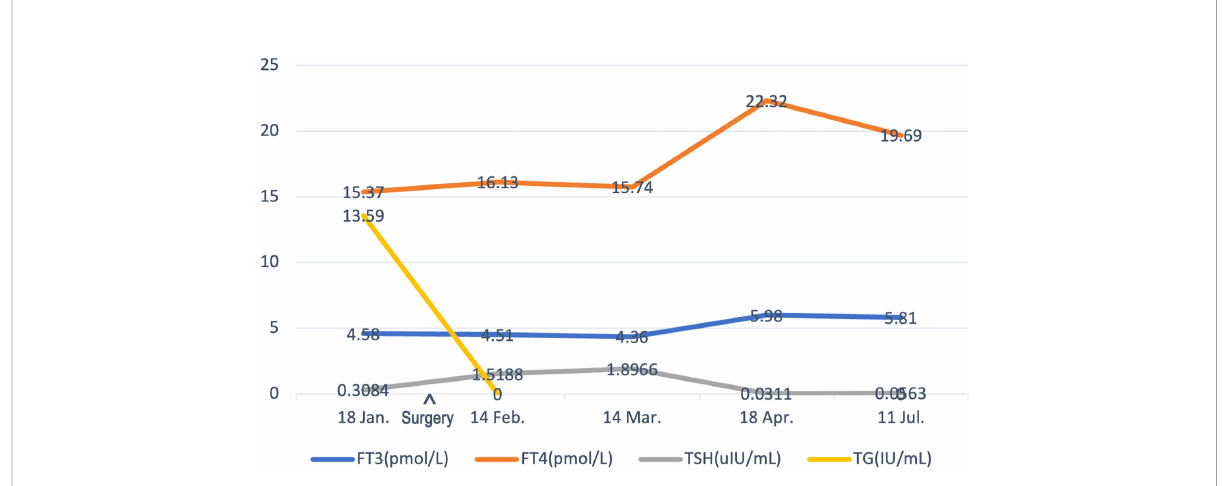
FIGURE 4 The timeline showcases the results of FT3, FT4, TSH, and TG levels of the patient before surgery and subsequent follow-ups. FT3, free triiodothyronine; FT4, free thyroxine; TSH, thyroid-stimulating hormone; TG,